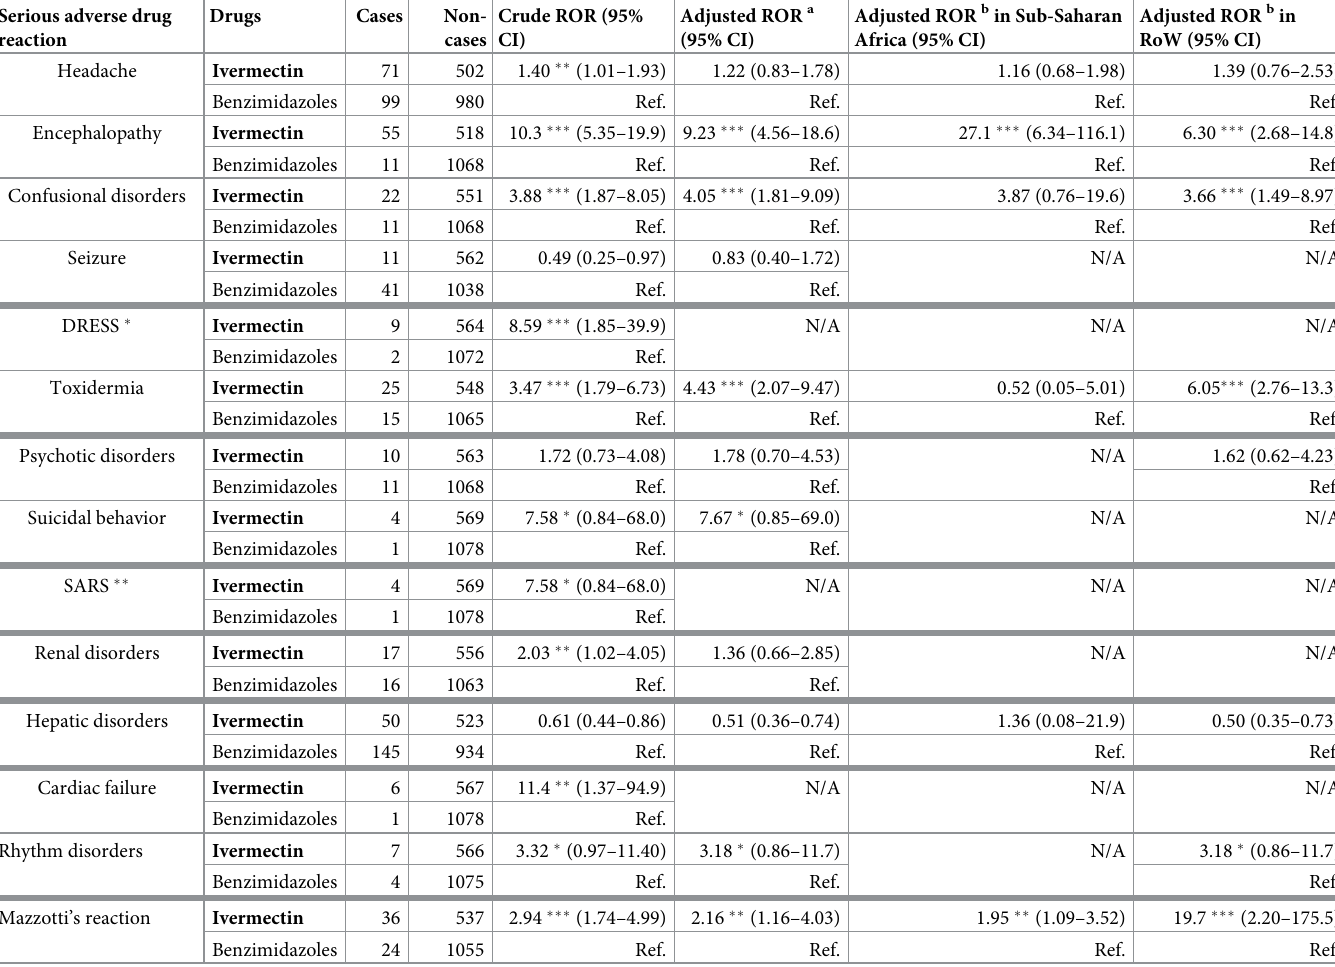
Table 6. Disproportionality analysis of serious adverse reactions associated with ivermectin compared to benzimidazole drugs. Serious adverse drug